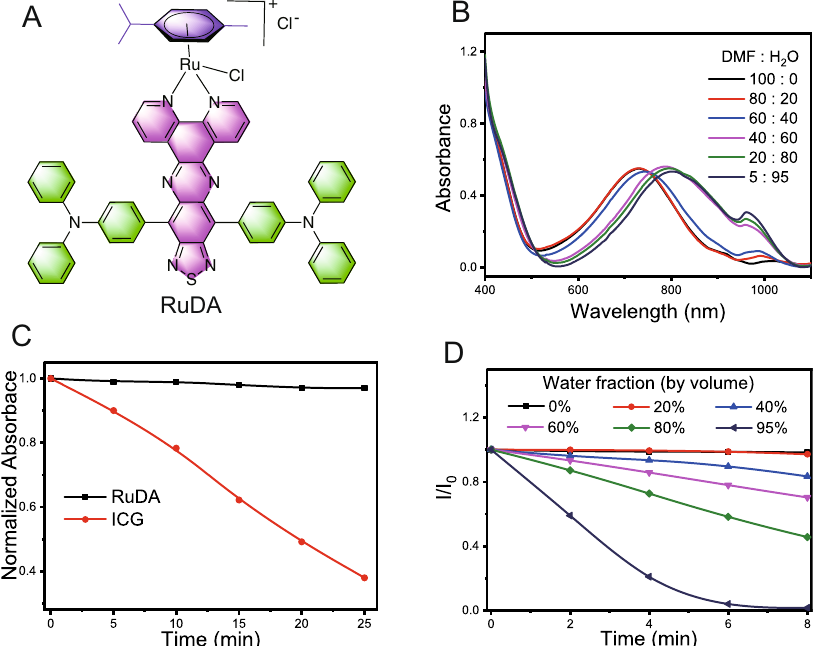
Fig. 2 Photo-physicochemical properties of RuDA. A Chemical structure of RuDA. B Absorption spectra of RuDA in mixtures of DMF and water at various ratios. C Time-dependent variation in the normalized absorbancevalues of RuDA (800nm) and ICG (779nm) under 808nm laser irradiation at0.5W cm − 2 . D Photodegradation of ABDA indicative of 1 O 2 generation induced by RuDA in DMF/H 2 O mixtures with different water fractions under 808nm laser irradiation at 0.5W cm − 2